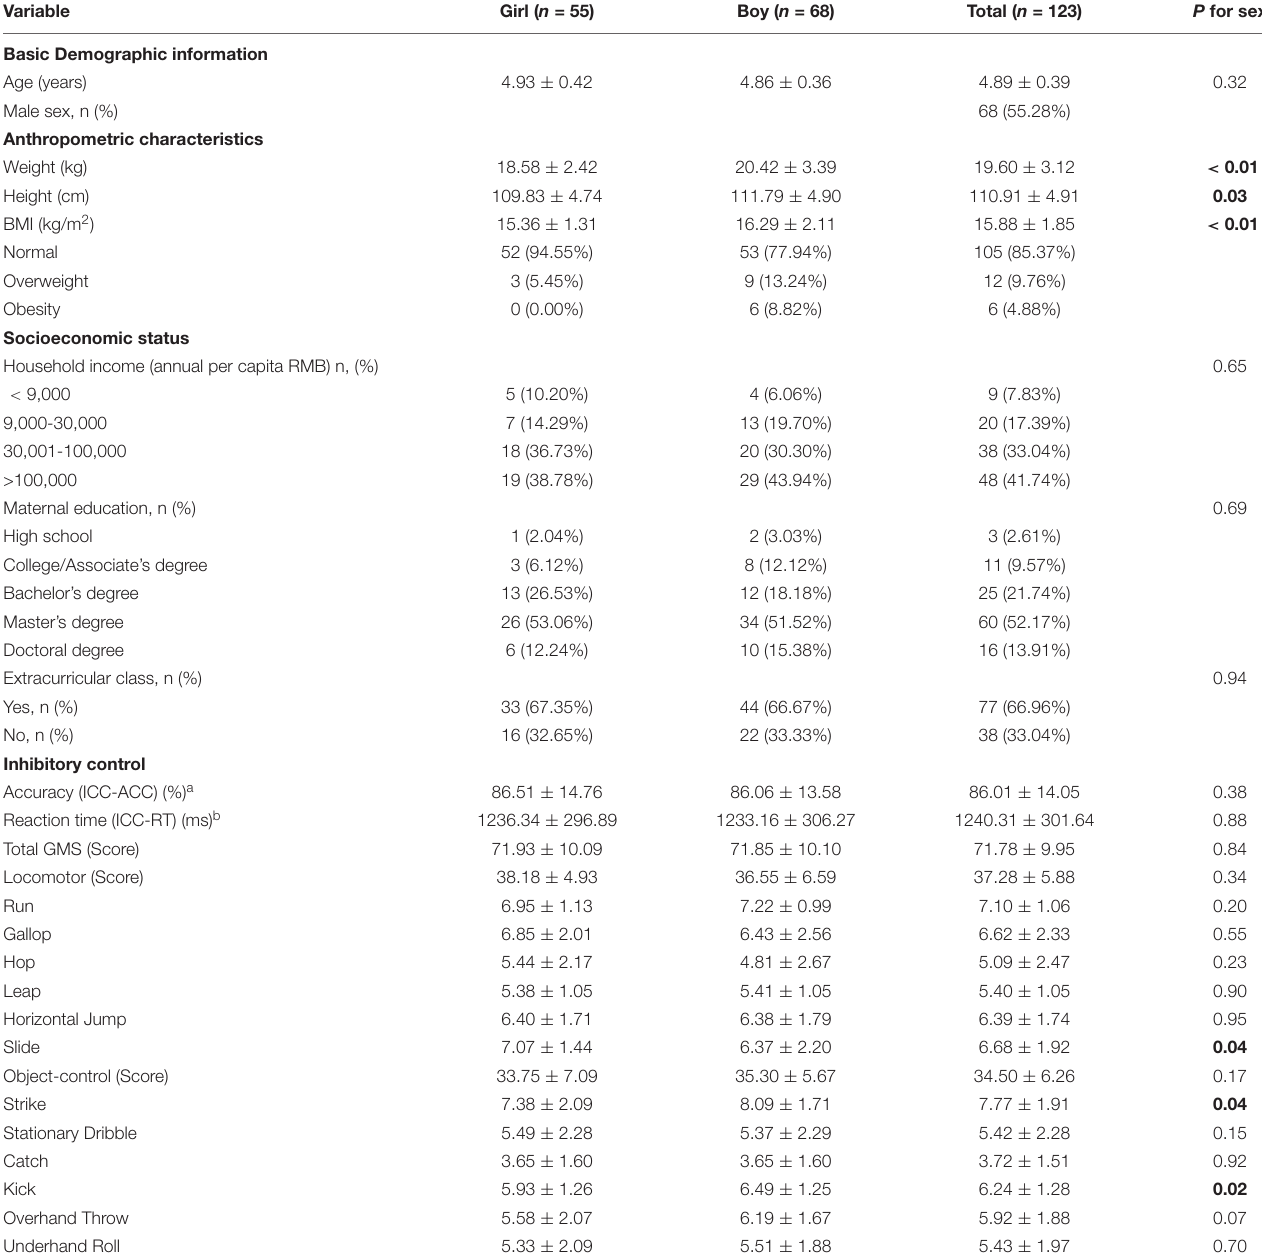
TABLE 1 | Characteristics of participants and parents and/or guardians and Gross Motor Skills and Inhibitory Control scores.